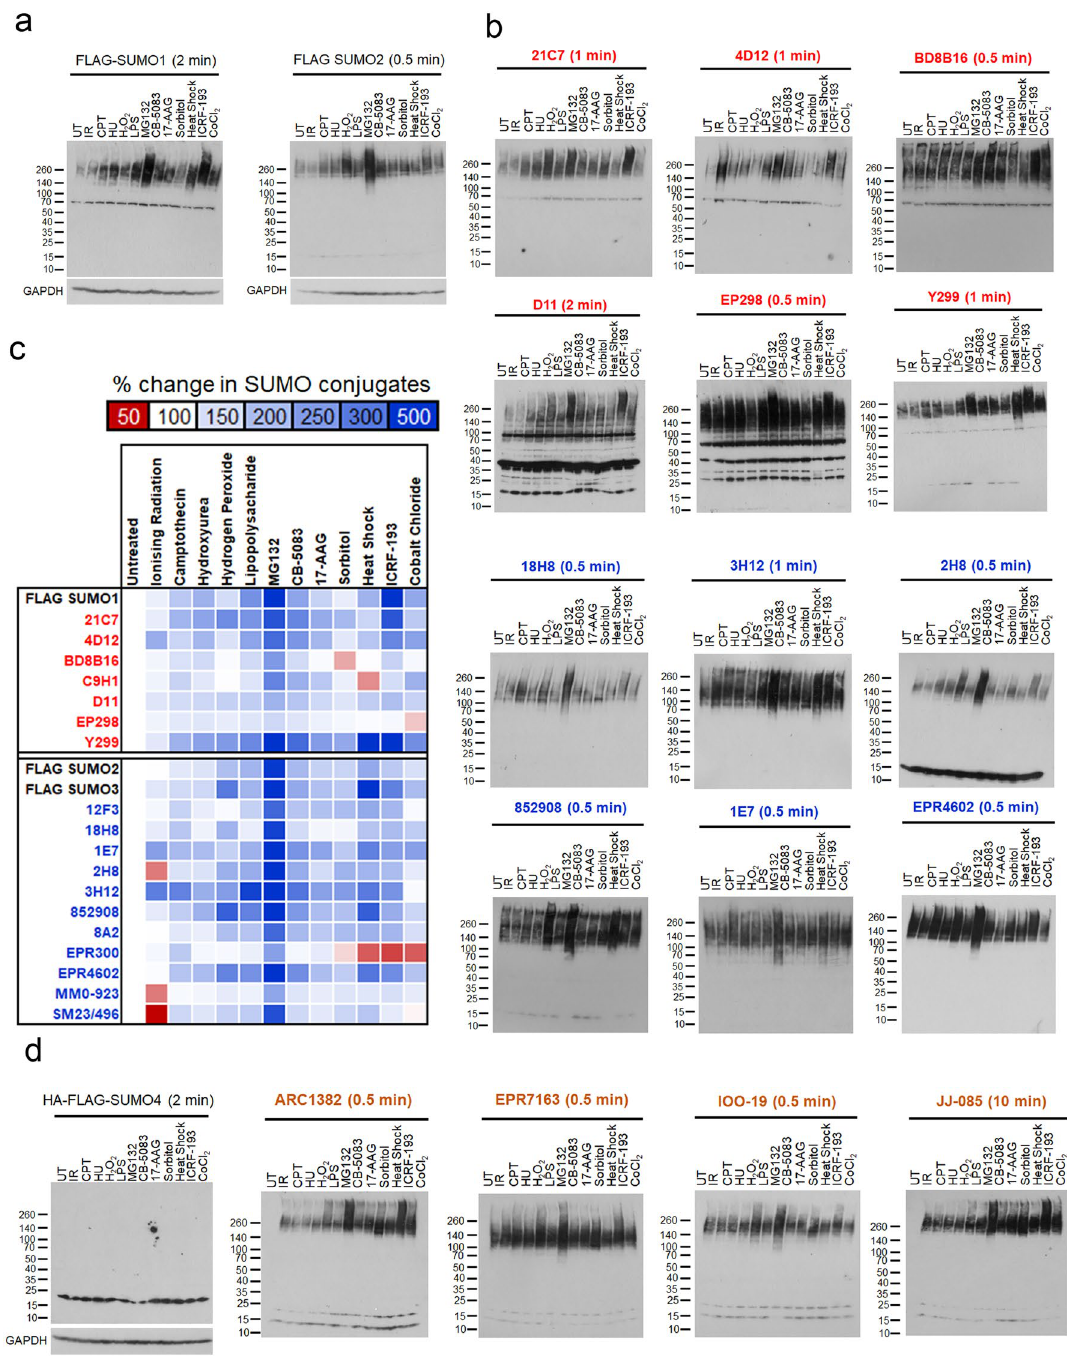
Figure 4. Detection of changes in SUMO conjugate states by cellular stress inducers. (a) U2OS cells treated with siRNA targeting endogenous SUMO1 or SUMO2/3 and doxycycline-treated to induce siRNA-resistant FLAG-SUMO1 or siRNA-resistant FLAG- SUMO2 for 48 h before treatment with indicated stress agents. UT (Untreated control), IR (Ionising Radiation, 4 Gy, 1 h post), CPT (Camptothecin 1 µM, 3 h), HU (Hydroxyurea 5 mM, 3 h), H 2 O 2 (Hydrogen Peroxide 125 µM, 15 min), LPS (Lipopolysaccharide 1000 ng, 3 h), MG132 (5 µg/mL, 3 h), CB-5083 (0.1 µM, 3 h), 17-AAG (5 µM, 3 h), Sorbitol (500 mM, 30 min), heat shock (42 °C, 10 min), ICRF-193 (100 µM, 1 h). Immunoblots were probed with anti-FLAG antibody. Exposure time is shown, all exposures are shown in Supplemental Fig. 4a,b. ( b) Representative immunoblots of lysates ( a ) probed with MAbs raised against SUMO1 in red (21C7, 4D12, BD8B16, D11, EP298 and Y299) and SUMO2/3 in blue (18H8, 3H12, 2H8, 852908, 1E7 and EPR4602) with exposure times shown. All exposures and Mabs tested are shown in Supplemental Fig. 4a,b. ( c) Heat map relative quantification summarising changes in signal after treatment for each SUMO1 or SUMO2/3 MAb. % Change calculated from three experimental repeats per MAb using densitometry of proteins migrating above 70 kDa as a % change relative to the untreated control lane for each immunoblot. Free SUMO was not included in the quantification. The mean for each condition and MAb is shown. Red indicates a reduction in SUMO conjugates relative to siNTC, white no change and blue an increase. ( d) U2OS cells treated with siRNA targeting endogenous SUMO4 and expressing siRNA-resistant FLAG-HA SUMO4 and treated as for ( a ). Lysates were then probed with MAbs raised to SUMO4 (orange). All exposures are shown in Supplemental Fig.